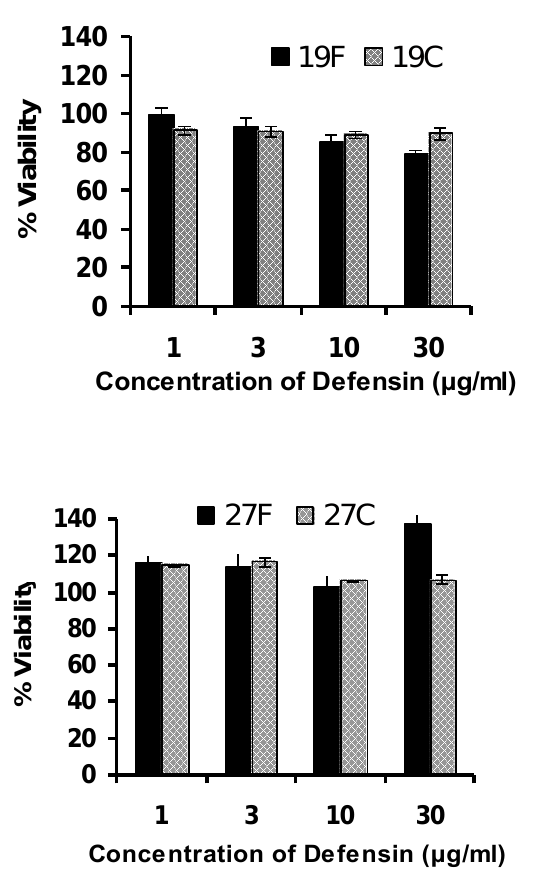
Figure 7. HBD cytotoxicity on human peripheral blood mononuclear cells (PBMCs). The cellular toxicity of folded (F) and crude (C) HBD-19, HBD-23, HBD-27, and HBD-29